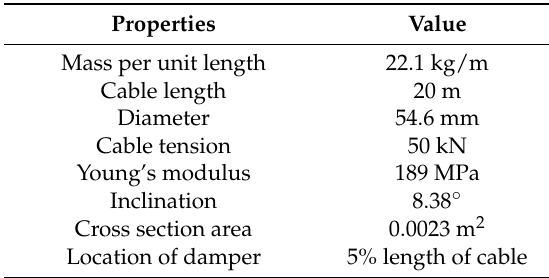
Table 4. Properties of the cable